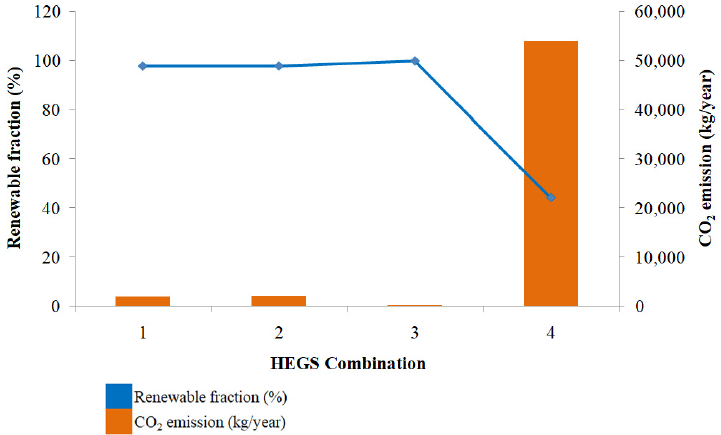
Figure 18. Comparison of CO 2 emissions & renewable fraction for selected HEGS combinations.